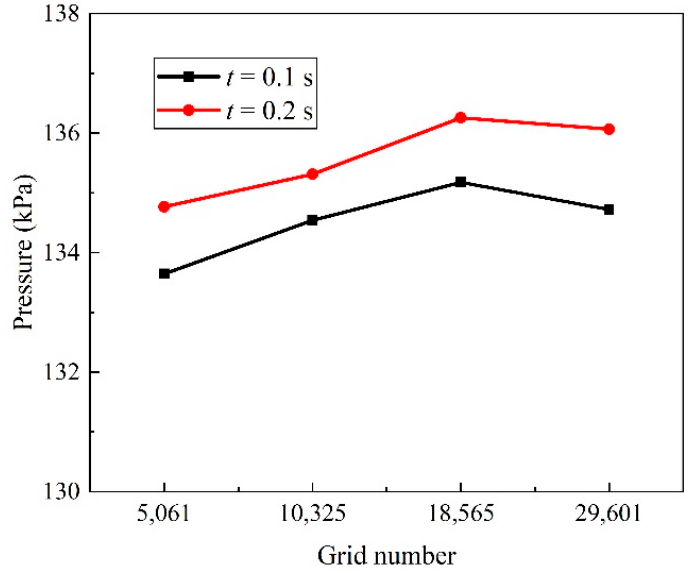
Figure 3. Pressure with various mesh numbers.